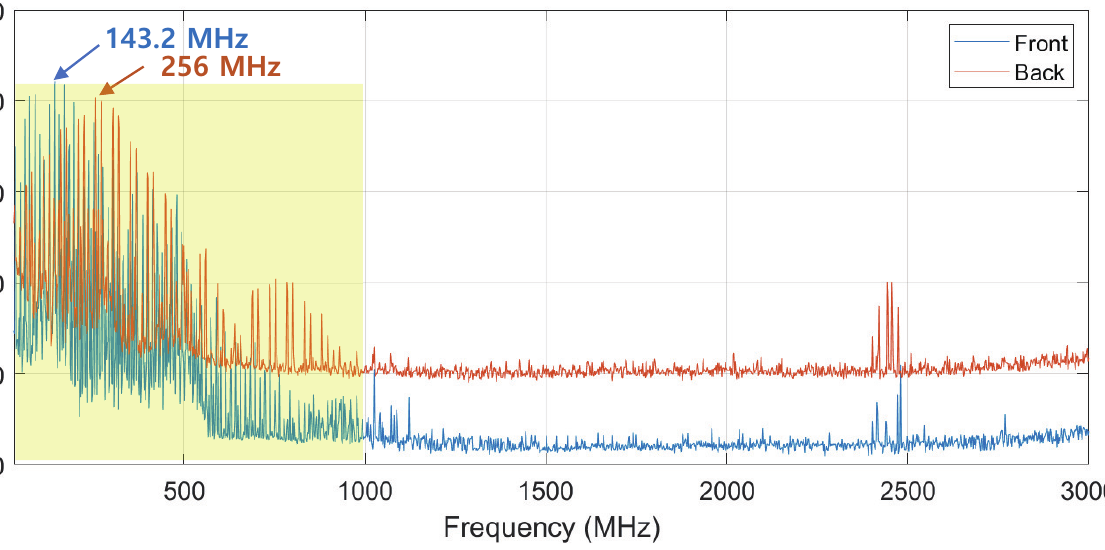
( a ) Near-field scanning result (30 MHz–3 GHz). Figure 5.